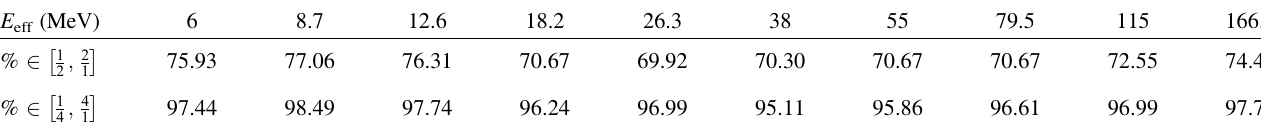
Table 3. Percentages of predictions within a factor of 2 and 4 of the data with the SEPEM